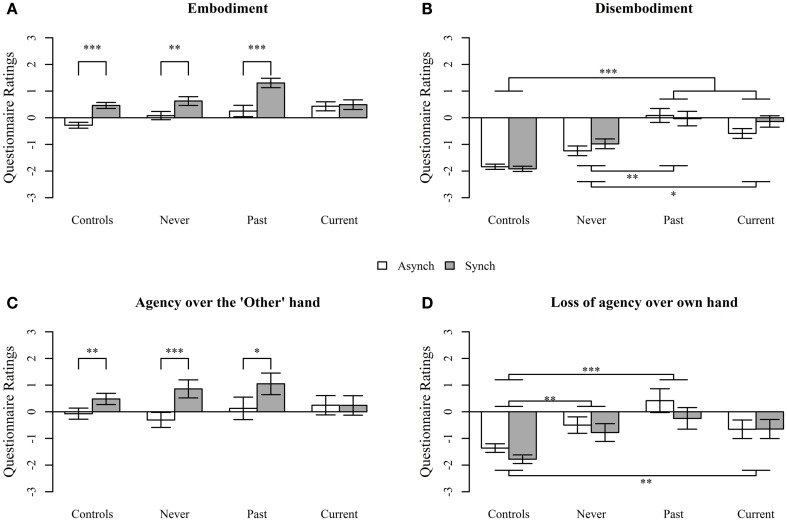
Questionnaire responses assessing (A) Embodiment, (B) Disembodiment, (C) Agency over the “Other” hand, and (D) Loss of agency over own hand, during the projected-hand illusion after asynchronous (Asynch) and synchronous (Synch) stimulation in controls, people with schizophrenia with no history of passivity symptoms (Never), people with a past history of passivity symptoms (Past), and people with current experiences of passivity symptoms (Current). Questions were answered on a 7-point Likert scale. Data are mean ± SEM. *p < 0.05, **p < 0.001, ***p < 0.0001.